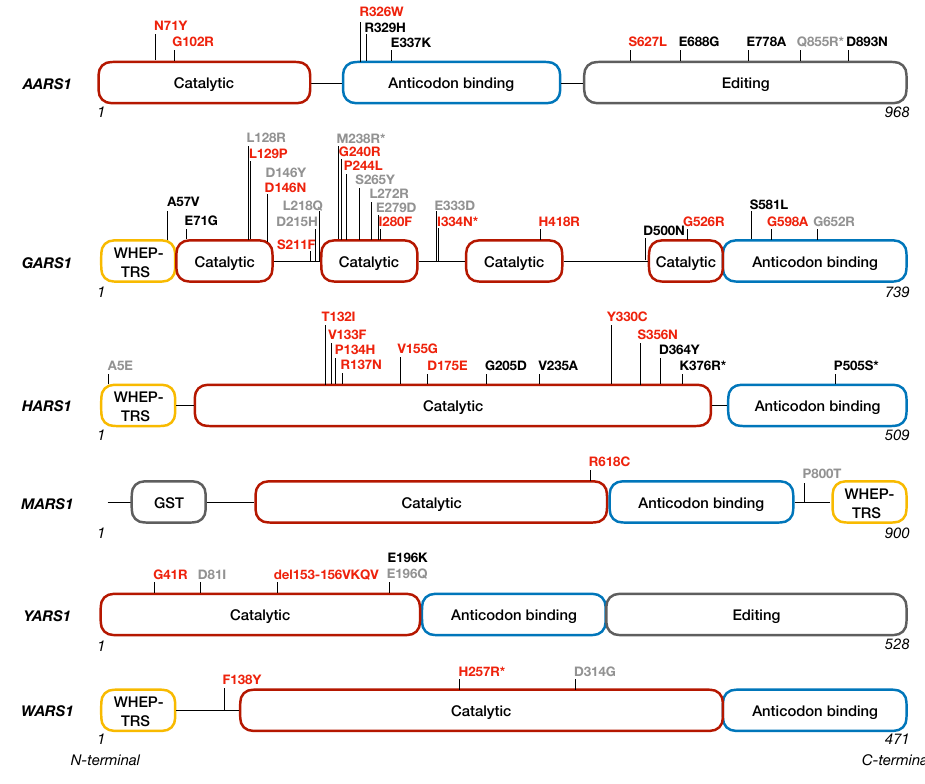
Figure 1. Schematic representation of the location of all CMT-causing dominant mutations reported to date in the domain structure of the corresponding aminoacyl-tRNA synthetases. The CMT mutations can be found in different functional domains. CMT-related mutations affecting the aminoacylation activity are indicated in red, mutations not impairing this activity are depicted in black. The mutations for which the aminoacylation activity remains to be investigated are indicated in grey. The mutations for which the amino acid is not conserved in D. melanogaster are labeled with an asterisk (*). The WHEP-TRS domain refers to a highly conserved helix-turn-helix domain of 46 amino-acids found in some of the aaRSs in higher eukaryotes. GST—Glutathione-S-transferase domain. Table 1. Aminoacyl tRNA-synthetases causing hereditary